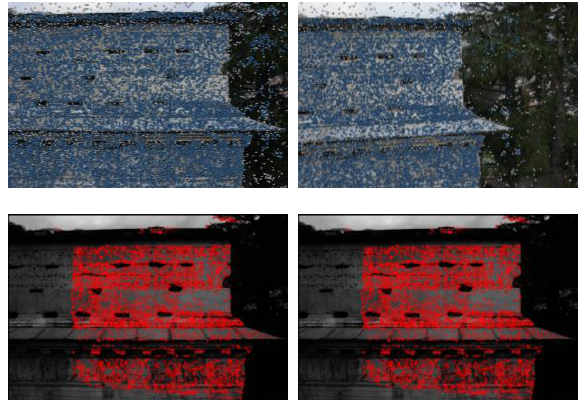
Figure 1 Visualization of the extracted TPs in two overlapped images (Agisoft Photoscan above, MicMac